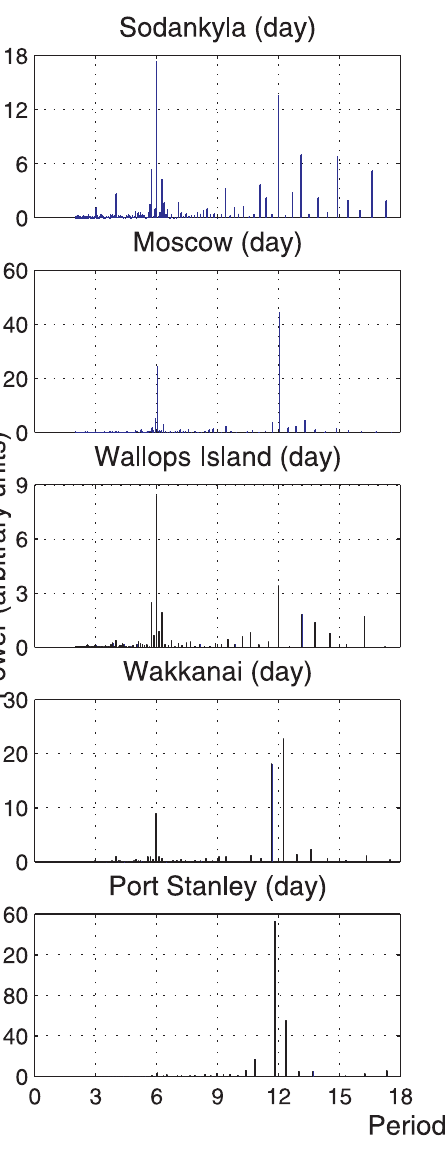
Table 2. Midday and night h mF2: amplitudes and phases from TIME-GCM model, F Station